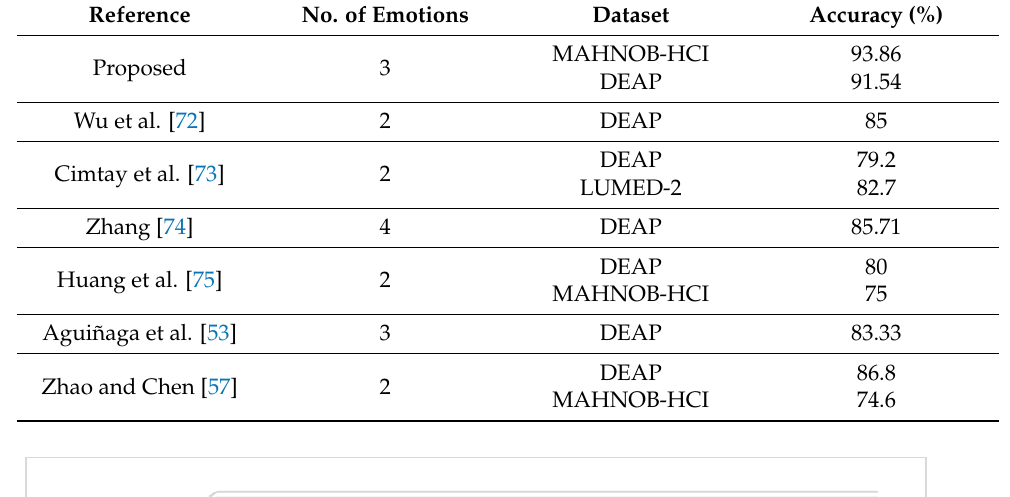
Table 10. Comparison of proposed method with other methods from literature in terms of datasets and number of emotion categories.